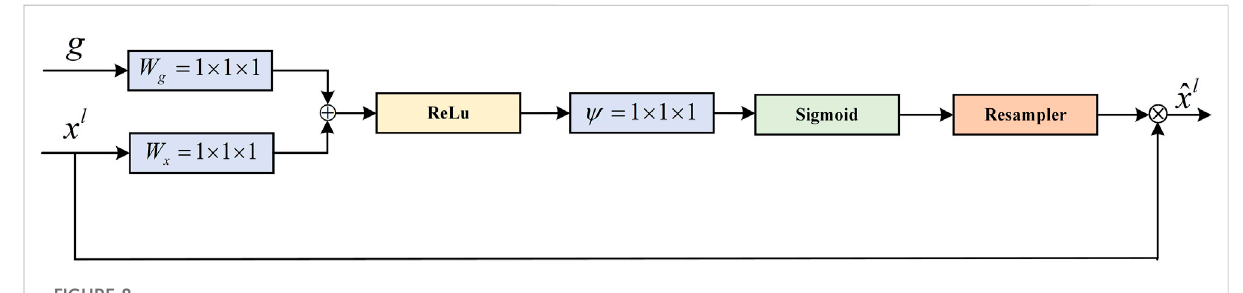
FIGURE 8 Schematic of the AG module (Oktay et al.,